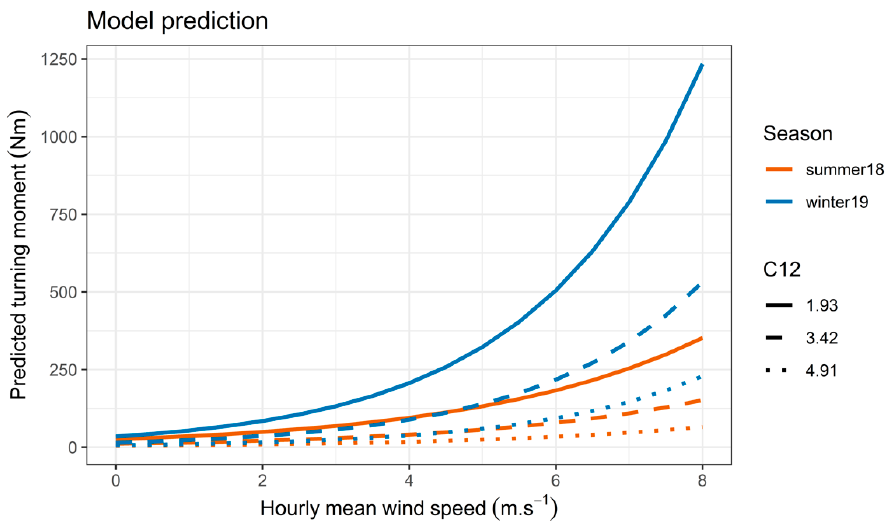
Figure 4. Predicted turning moment during winter and summer as a function of C 12 . Turning moment values are only provided for illustration of competition and season because of the bias introduced in the back transformation of the logarithmic values